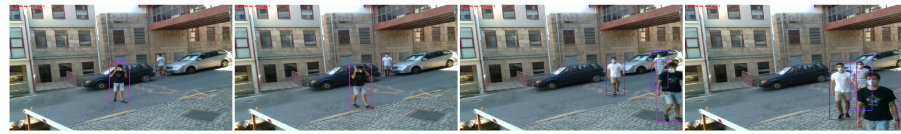
Figure 4. Multi-person tracking example employing the FAIRMOT tracker